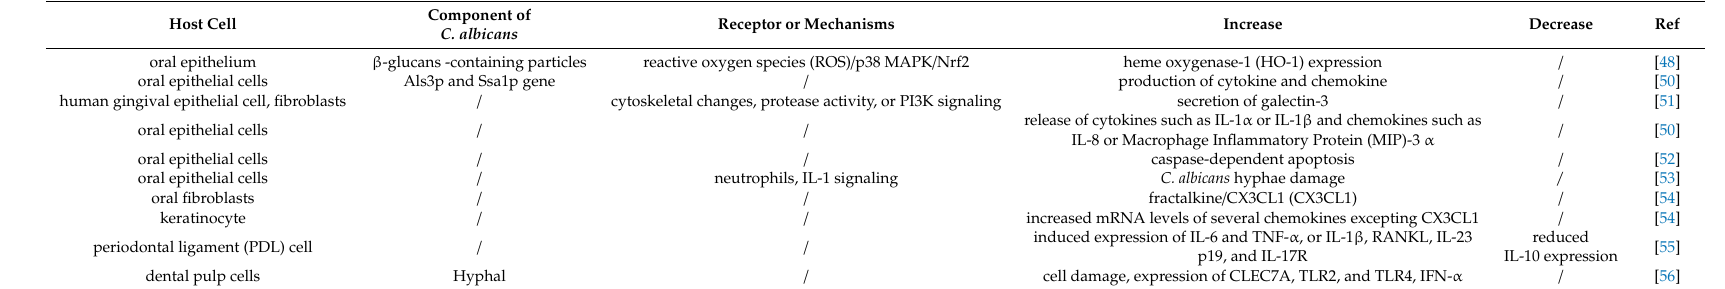
Table 2. Recognition of Candida albicans by non-immune